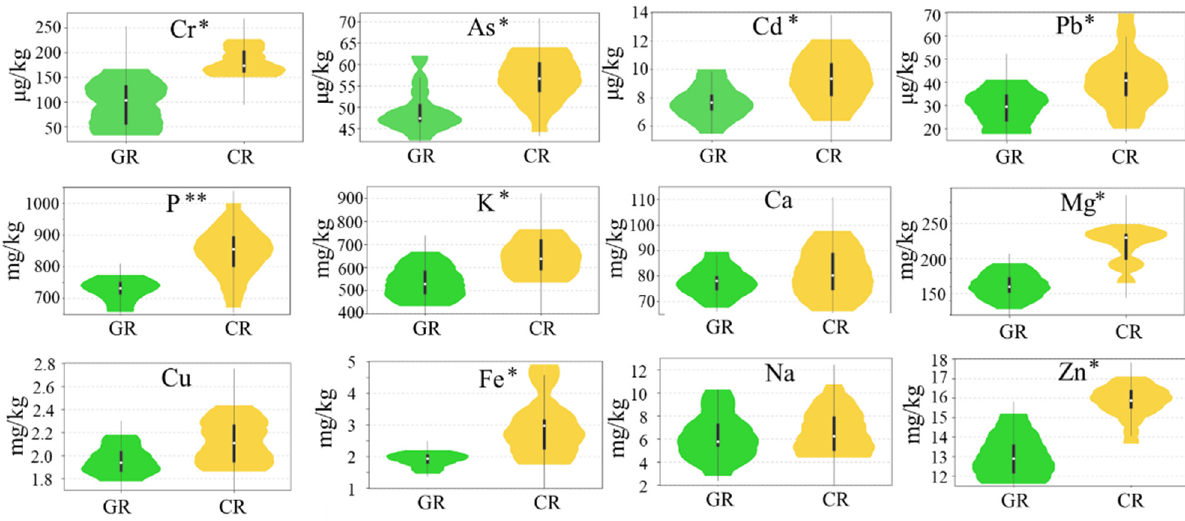
Figure 1. Violin plot of toxic elements and essential elements in the green rice (GR) and conventional rice (CR) systems (* p < 0.05, ** p < 0.005).